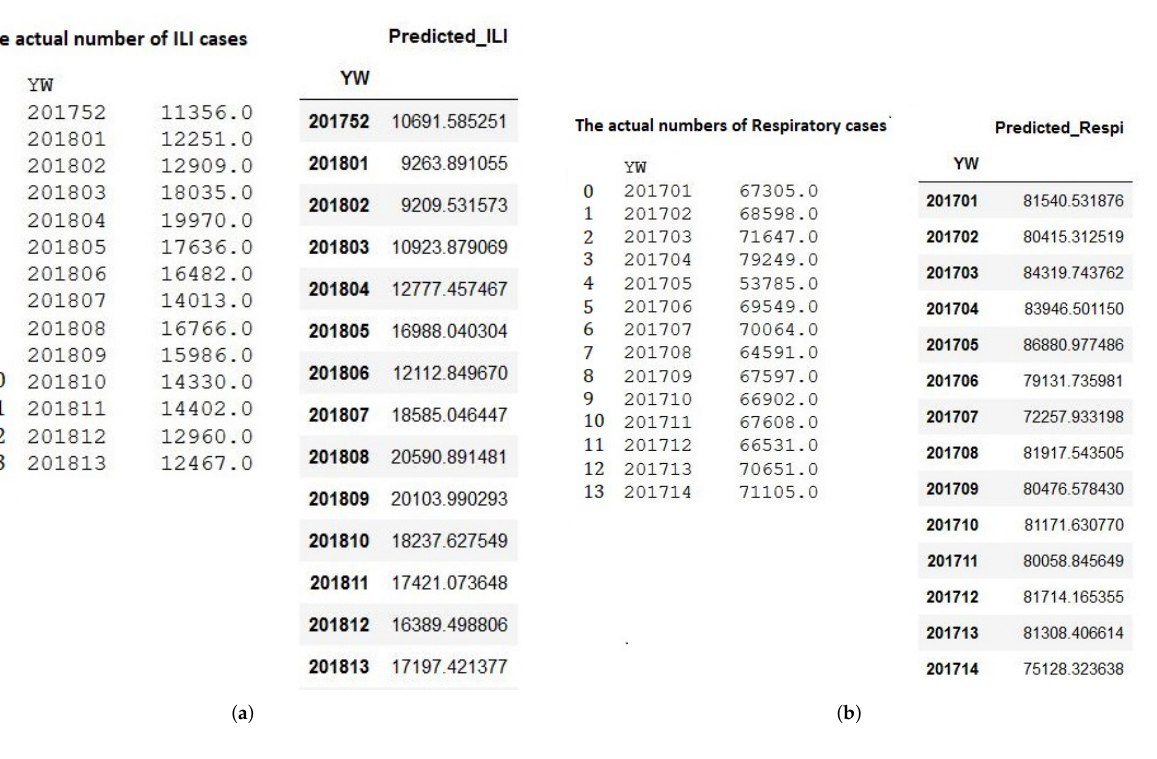
Figure 8. The Prediction sampling of ARIMA. ( a ) ARIMA ILI 5 years; ( b ) ARIMA Respiratory 10